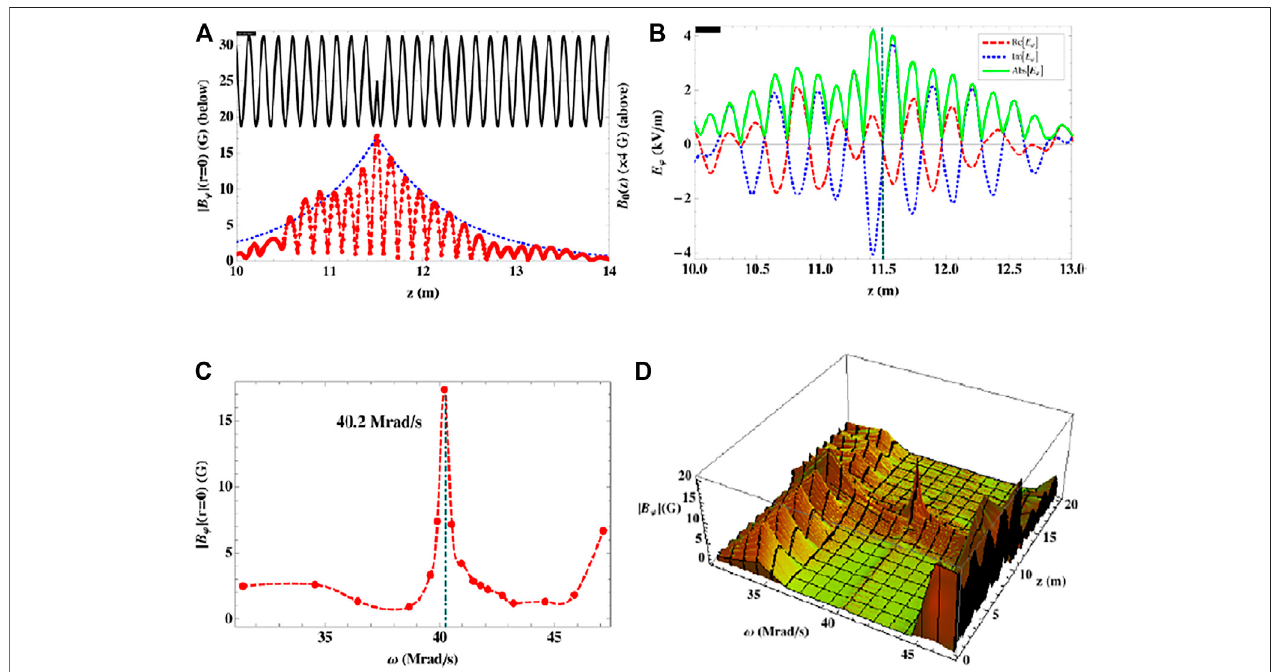
FIGURE4| Gapeigenmodeofheliconwavepropagatinginaperiodicstructure withlocaldefect.Reproducedfrom[35],withthepermission ofIOPPublishing. (A) Longitudinal pro fi les of the static magnetic fi eld (solid line) and the rf magnetic fi eld on axis (dots), together with the theoretically calculated envelope (dotted line); (B) longitudinal pro fi le of the rf electric fi eld (on-axis) (vertical dot-dashed line marks the defect location, and solid horizontal bar marks the antenna); (C) resonance in the dependence of the on-axis amplitude of the rf magnetic fi eld on driving frequency at the location of the defect; (D) 3D plot of the on-axis wave fi eld strength.